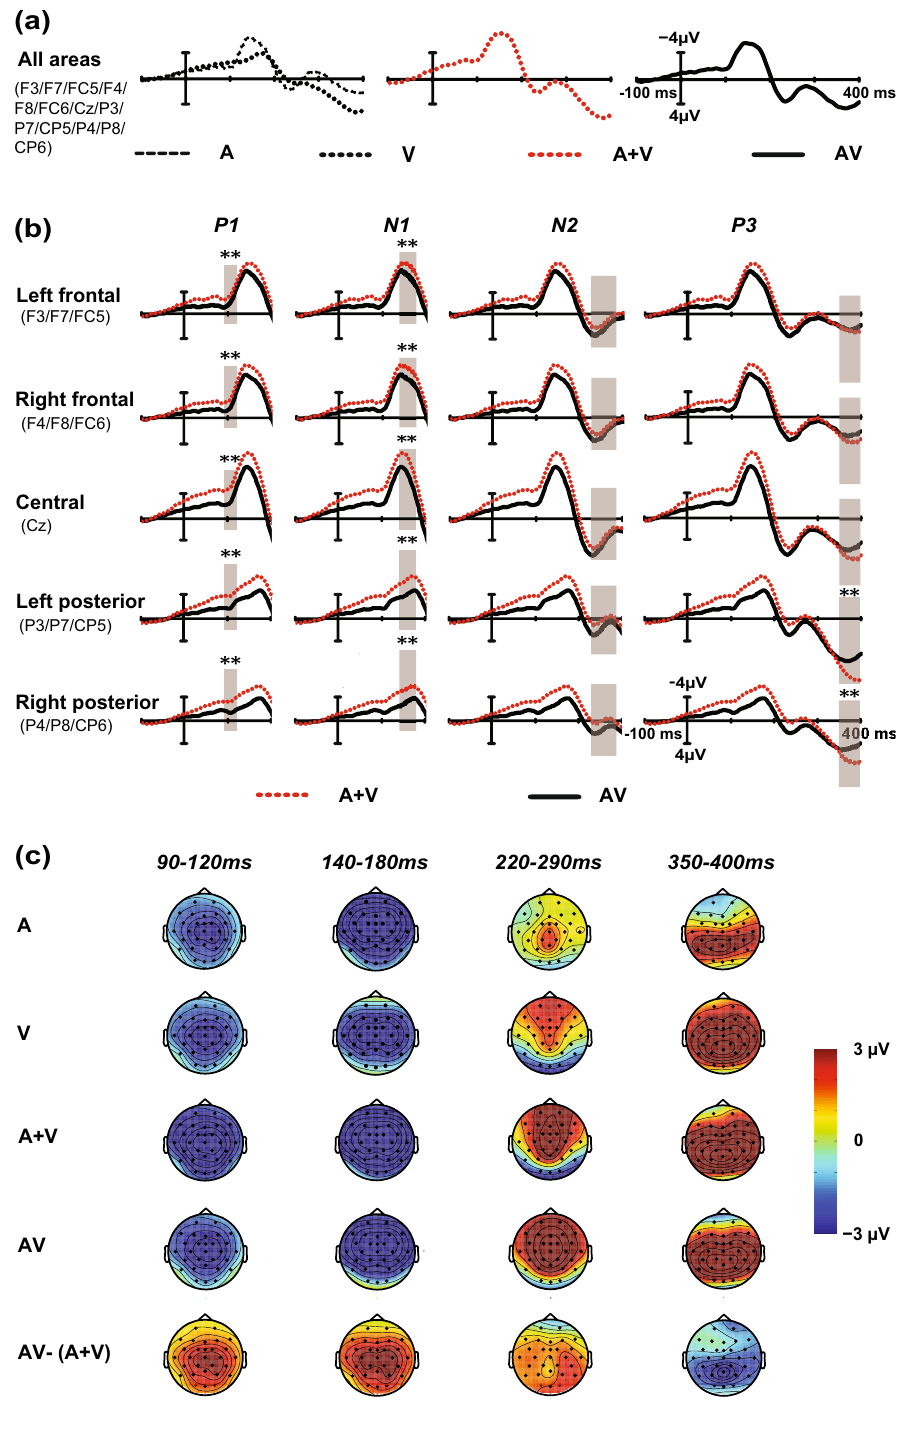
Figure 5. Multisensory integration effect for the AV targets. Panel ( a ) displays the mean ERP waveforms of 13 electrodes to A (black broken), V (black dotted), A + V (red dotted) and AV (black solid). The five regions of ERP waves in panel ( b ) depicts the distribution of the multisensory integration effect in four windows, shown separately for the 90–120 ms, 140–180 ms, 220–290 ms, and 350–400 ms windows. Significant difference between the bimodal AV (black solid) and summed unimodal A + V (red dotted) ERP waveforms (sig. two- tailed; 95% confidence interval, CI), reflecting a multisensory integration effect for the AV targets and marked by the symbol ‘**’ ( p < 0.01). Scalp topographies of unimodal A, unimodal V, summed unimodal A + V, and bimodal AV and the AV-(A + V) processing are depicted in panel ( c